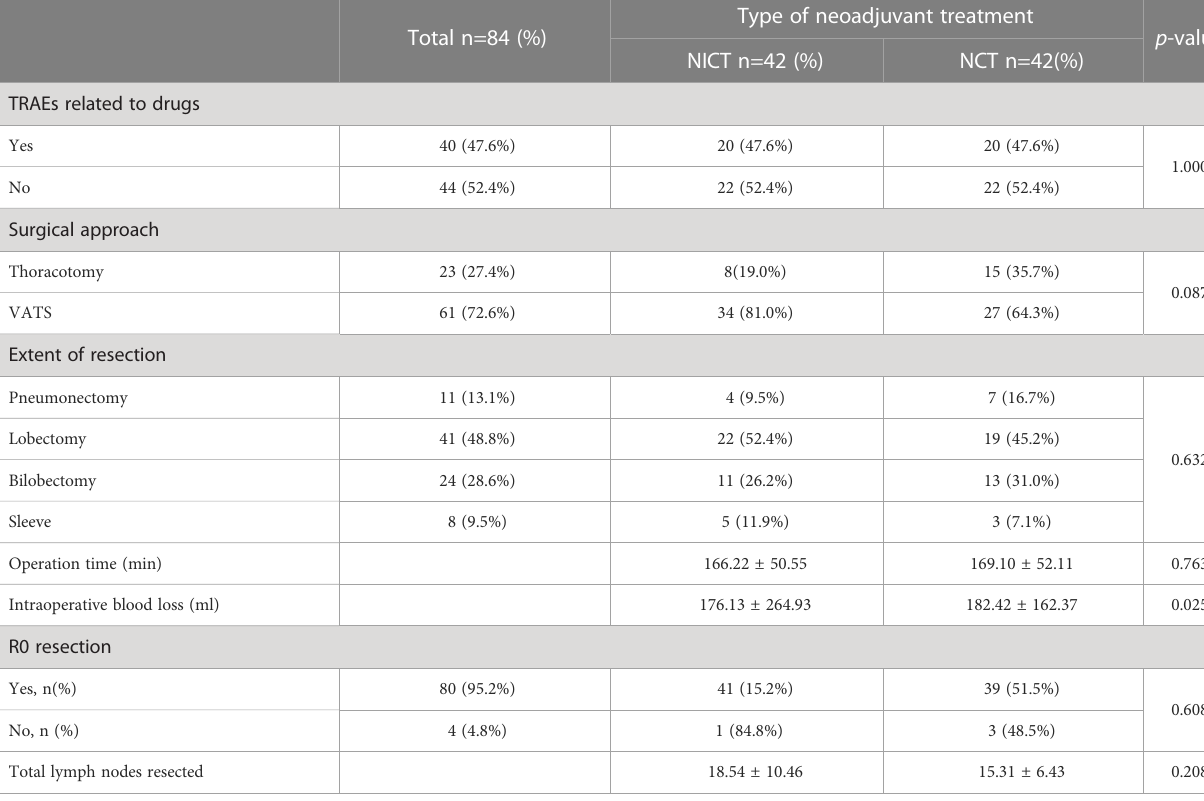
74.2% and 53.5% in the NICT and NCT groups, respectively ( P = lymph node dissections. The blood loss from the patients in the 0.009). The pathological analysis after surgery showed signi fi cantly NICT group was still lower than that from the patients in the NCT higher MPR in 44 patients (66.7%) in the NICT group as compared to that in 21 patients (20.8%) in the NCT group ( P < 0.001). The pCR rate was also signi fi cantly higher in the NICT group than that in the NCT group. (45.5% vs. 10.9%, P < 0.001). After PSM, there was no signi fi cant difference in ORR between the NICT and NCT groups (52.3% vs. 43.2%, P = 0.118), and the proportions of MPR As listed in Table 5, radiographic response evaluation was (76.2%) and pCR (50.0%) were signi fi cantly higher in the NICT performed in all the patients before surgery, showing the ORR of TABLE 4 Comparison of treatment modality and surgical outcomes for NSCLC patients after